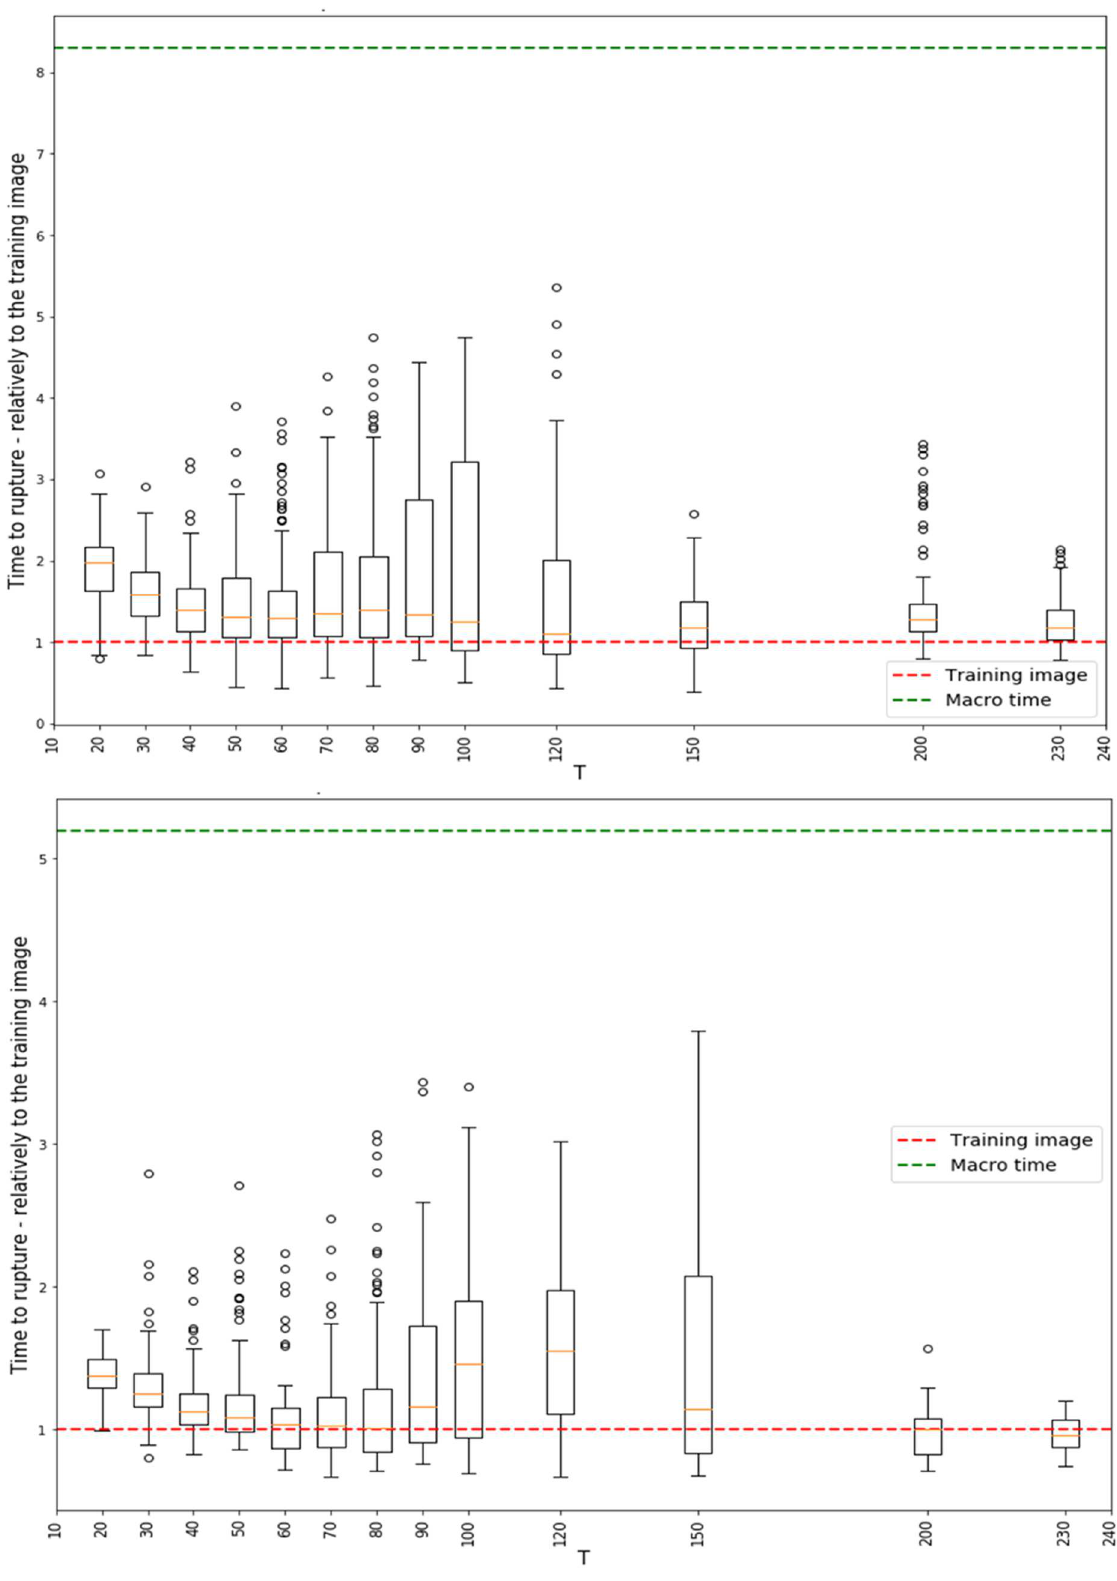
Fig. 16. Times to rupture of 1 300 realizations for varying T and OL , at a macroscopic strain (cid:15) = 1% (top) and (cid:15) = 12% (bottom) alongside with the time to rupture of the corresponding training image, and the macroscopic time. The times are displayed relatively to the one of the training